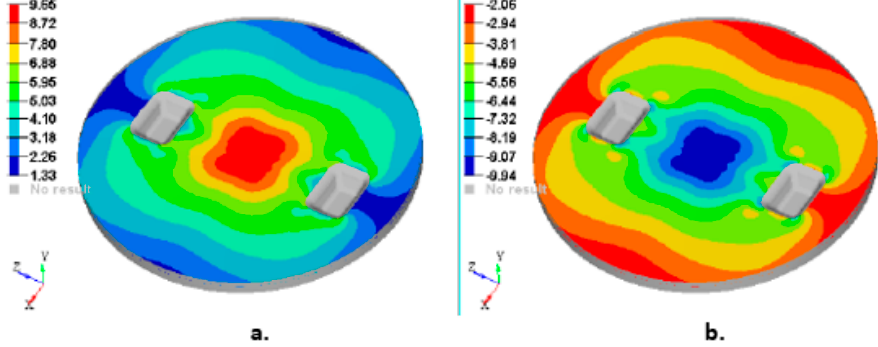
Materials 2019 , 11 , x FOR PEER REVIEW 13 of 17 Figure 19. Plot of the Von Mises stress distribution on the manhole cover analysed. Figure 19. Plot of the Von Mises stress distribution on the manhole cover analysed. Figure 19. Plot of the Von Mises stress distribution on the manhole cover analysed.